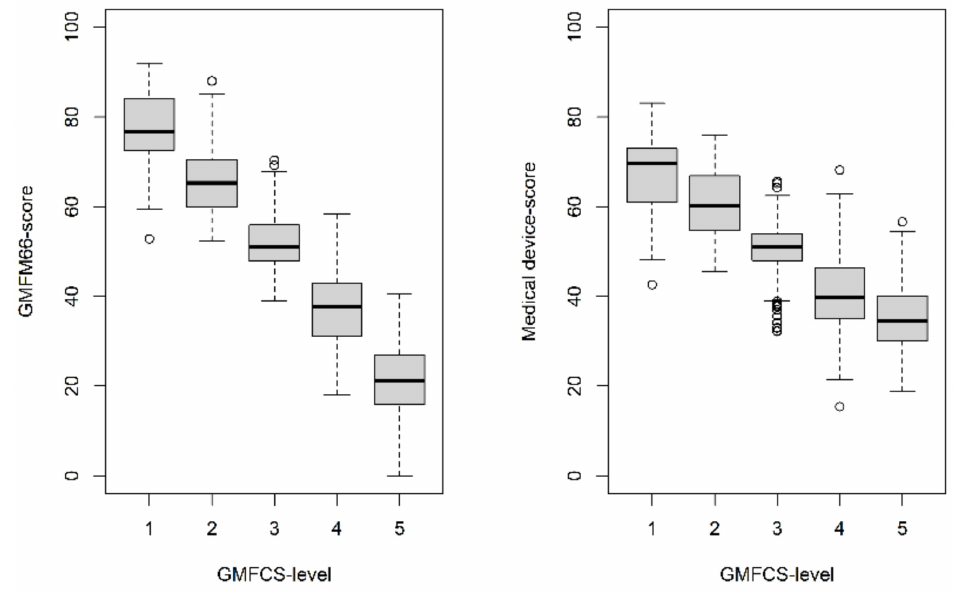
Figure 2. Comparison of GMFM-66 score and MDS by